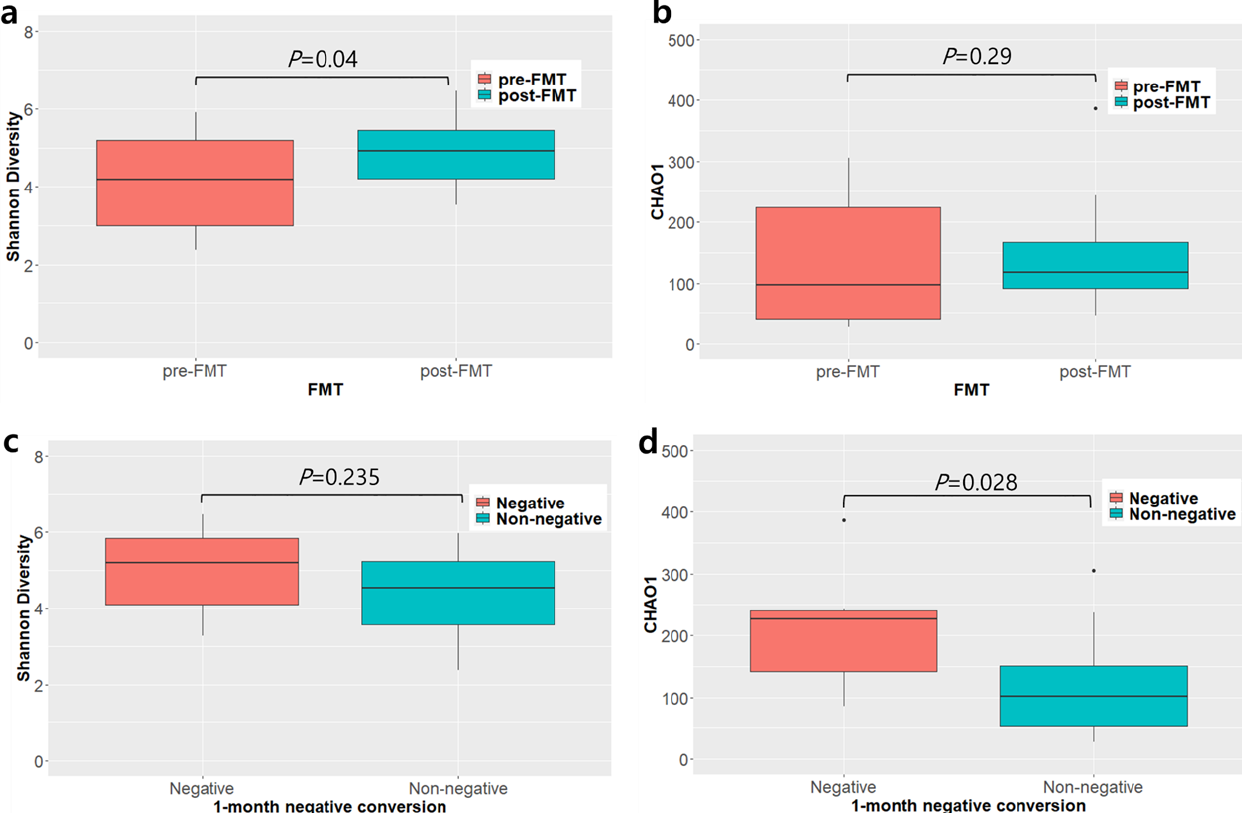
Figure 6. Difference in alpha-diversity. ( a ) Shannon index diversity of the pre- and post-fecal micro- biota transplantation (FMT) groups. ( b ) Chao1 diversity of the pre- and post-FMT groups. ( c ) Shan- non index diversity of the 1-month negative-conversion and 1-month non-negative-conversion groups. ( d ) Chao1 diversity of the 1-month negative-conversion and 1-month non-negative-conver- sion groups.